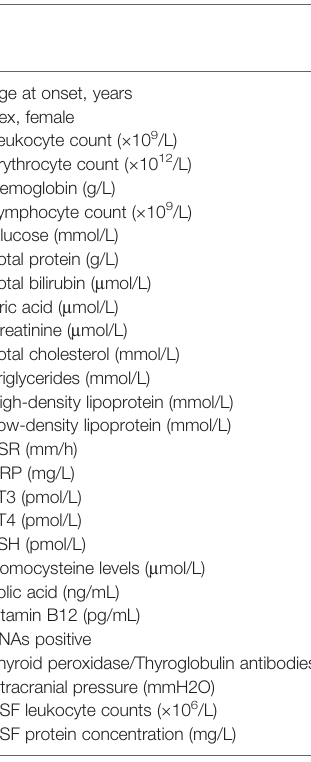
TABLE 5 | Laboratory data according to initial Expanded Disability Status